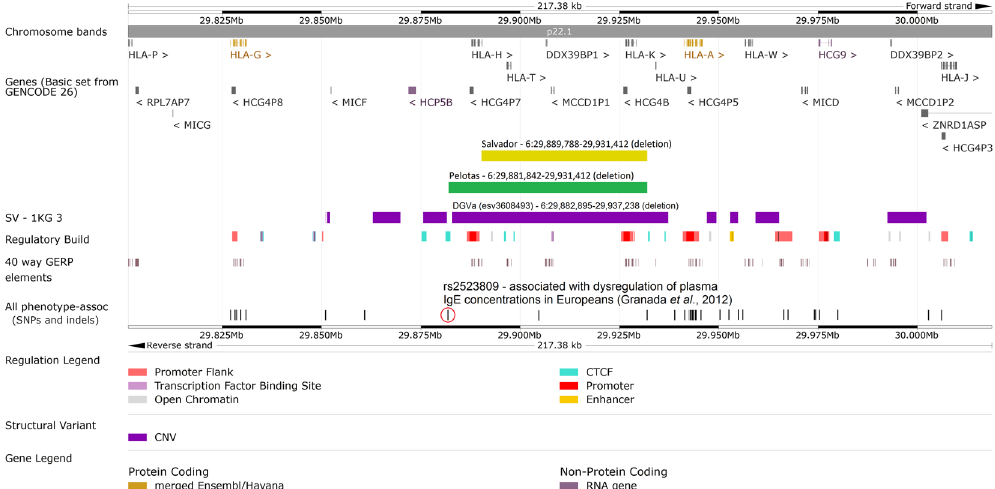
Figure 2. In silico functional study on the regulatory potential of the deletion at 6p22.1. Schematic representation of the locus containing the deletion region associated with asthma in Brazilian populations (expanded view: 6:29,801,381–30,018,756; RefSeq: GRCh38). This region was cross-referenced with DNA sequence annotations, including: location of protein coding or non-protein coding genes (GENCODE 26); presence of large structural variations identified by the 1000 genomes project, phase 3 (SV – 1KG 3); position of putative regulatory elements (regulatory build); location of constrained elements for 40 eutherian mammals (GERP, Genomic Evolutionary Rate Profiling); presence of SNPs and short indels associated with any human phenotype in previous studies. Limits of the deletions found in samples from Salvador or Pelotas are symbolized by a yellow or a green bar, respectively. Image created using the Ensembl genome browser